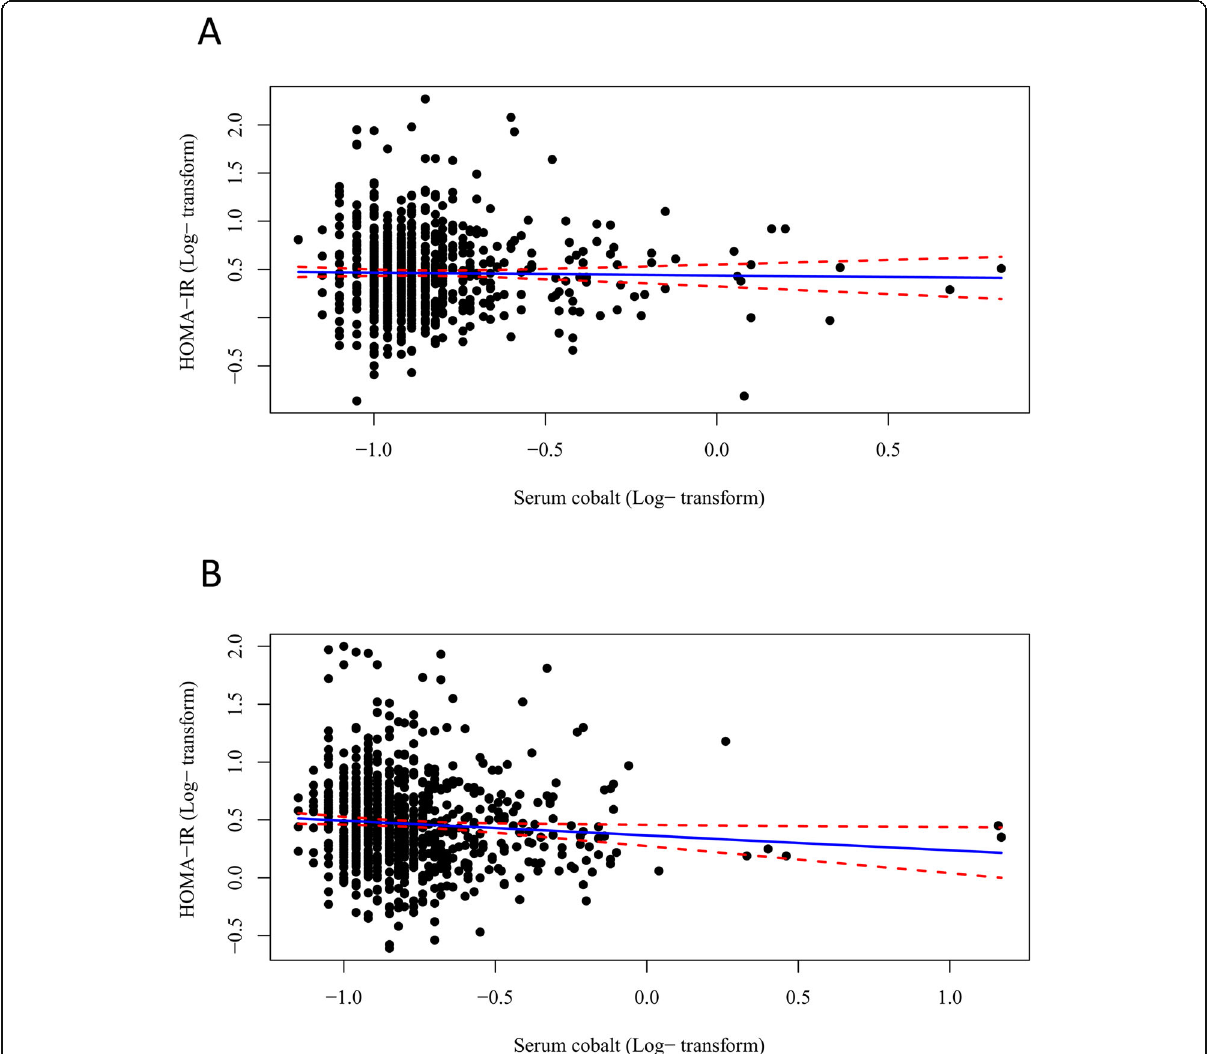
Fig. 3 A scatter plot and a fitted line with 95% CI showing the relationship between blood cobalt levels and HOMA-IR in male and female